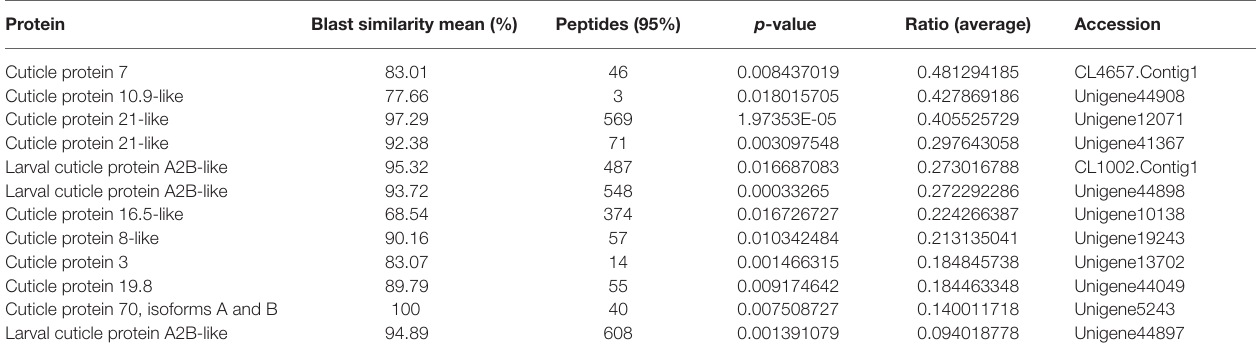
TABLE 3 | Cuticle proteins and homologies in 20 + U73122-treated A. lucorum . Protein Blast similarity mean (%) Peptides (95%) Cuticle protein 2-like